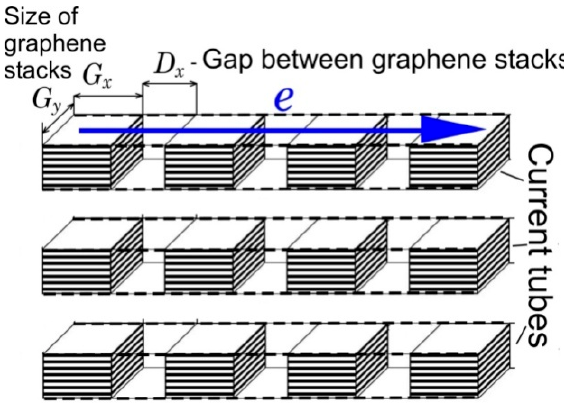
Figure 16. Model of conduction of disordered carbon within current tubes of sequentially arranged stacks of graphene layers.